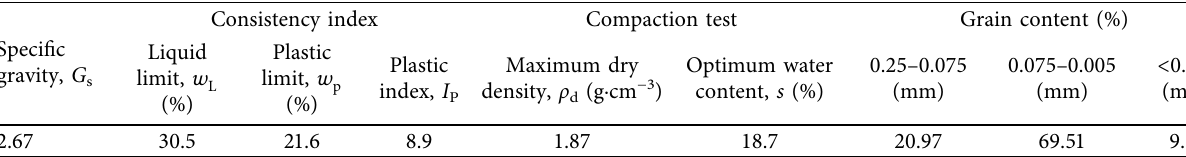
Table 1: Physical properties of saline soils.